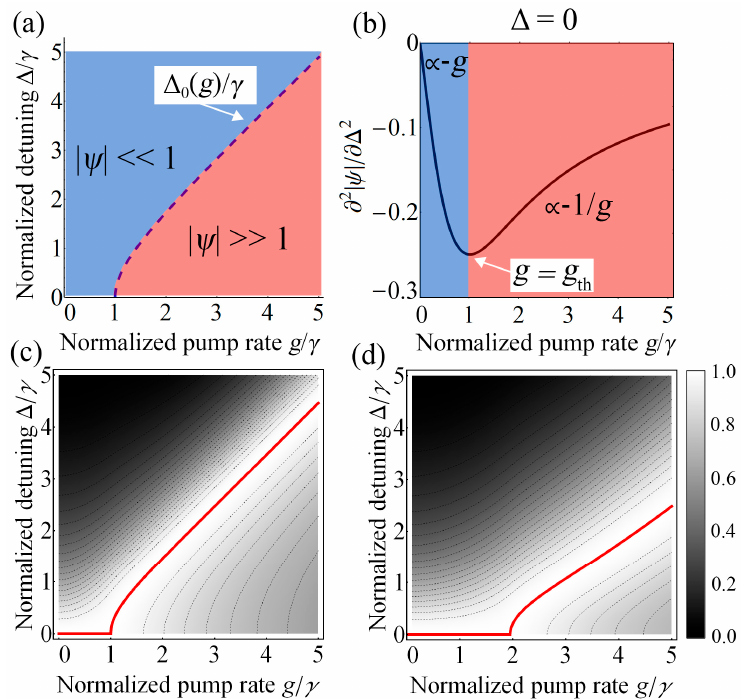
Figure 4. ( a ) Phase diagram of the modulus of anomalous average | ψ | in 2D space of the two-photon pump rate g and the frequency detuning Δ in units of the two-photon dissipation rate γ , obtained from the mean-field theory. Critical boundary Δ 0 ( g ) (blue dashed line) separates the phases with low (blue area) and large (red area) average number of photons. ( b ) The behavior of the second derivative ∂ 2 | ψ | / ∂Δ 2 vs the pump rate g for Δ = 0. One can see the existence of two regimes, in which switching occurs after passing the threshold point g th = γ . ( c , d ) Heat maps of the normalized susceptibility χ = ∂ | ψ |/ ∂ g as a function of a normalized pump rate g and frequency detuning Δ obtained from ( c ) mean-field analytic solution (19) and ( d ) numerical simulation of the master equation. The red line identifies the location of the maximum susceptibility and indicates that the critical behavior occurs only after passing the cutoff pump rate g th . The susceptibility χ is normalized by the maximum value for each frequency detuning Δ .